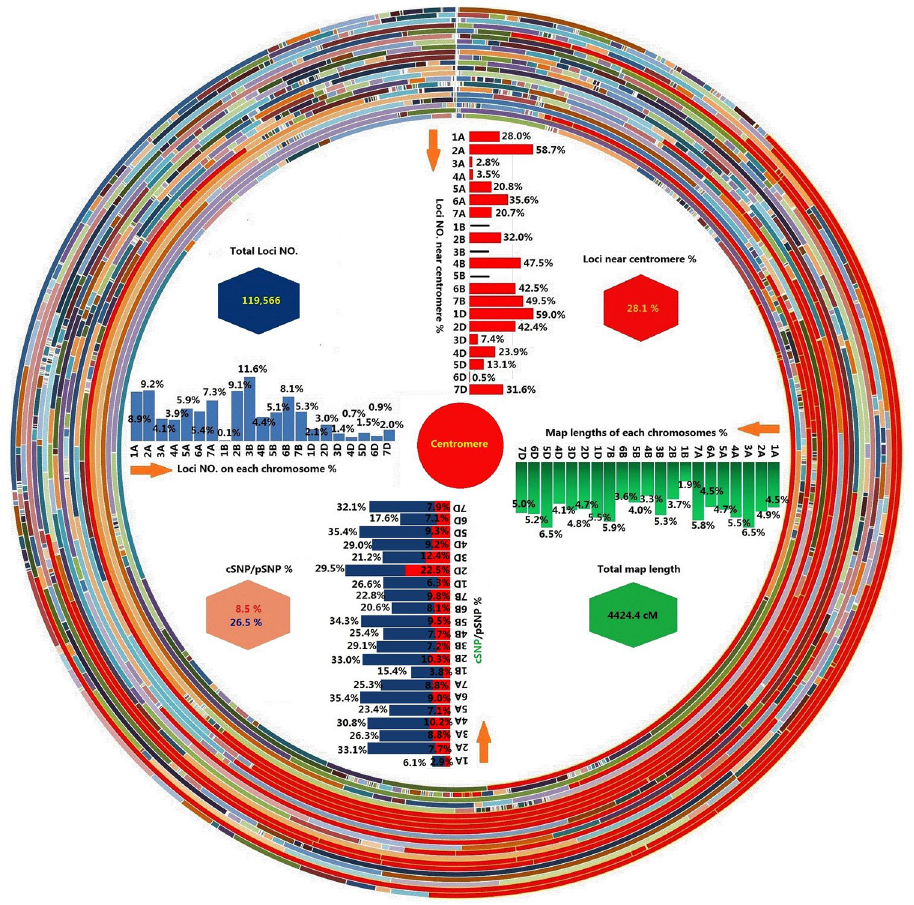
Figure 1. Distribution of the 119 566 loci on the 21 wheat chromosomes. The 21 circles indicate the 21 wheat chromosomes, with 7D to 1D, 7B to 1B, and 7A to 1A from inside to outside, respectively. Each chromosome was evenly divided into 100 segments based on the map length, which are shown with different colours. The arc lengths indicate the percentage of markers on each segment (The total number of markers on the corresponding chromosome divided by the number of markers on the segments). The arc in red colour indicates the chromosomal bins near the centromere. The upper left histogram in the circle indicates the distribution of markers on each chromosome; the upper right histogram in the circle indicates the distribution of markers near the centromere on each chromosome; the bottom right histogram in the circle indicates the distribution of map length on each chromosome; the bottom left histogram in the circle indicates the distribution of markers in/ near the coding